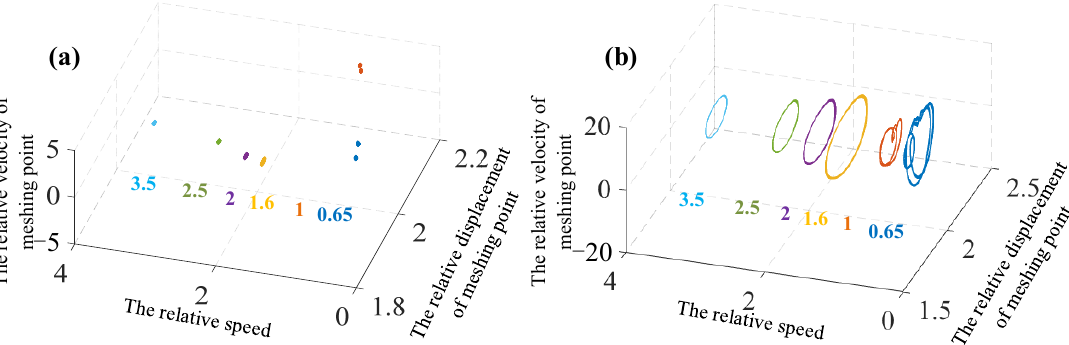
Figure 20. System response diagram with ζ = 0.05. ( a ) Poincare section diagram. ( b ) Phase diagram.